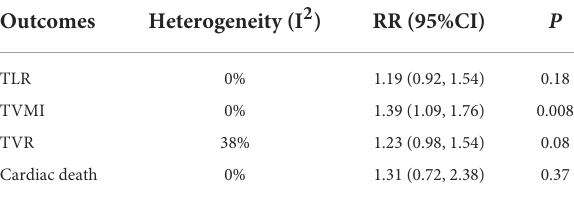
TABLE 2 Meta-analysis results on other